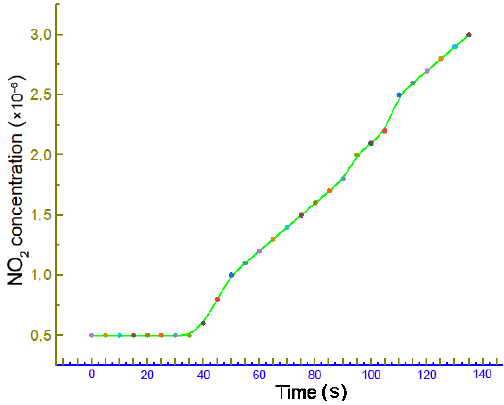
Fig. 4 Experimental result of humidity and temperature level in air.